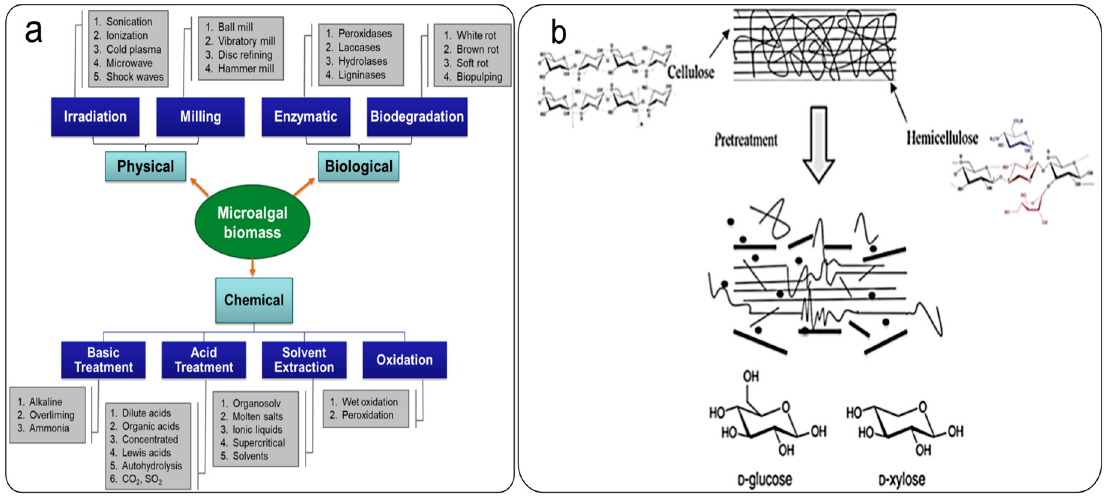
Figure 4. Physical, chemical, and biological pretreatment methods: pretreatment of biomass showing the structure of cellulose and hemicellulose ( a ) and their hydrolysis to glucose and xylose ( b ).